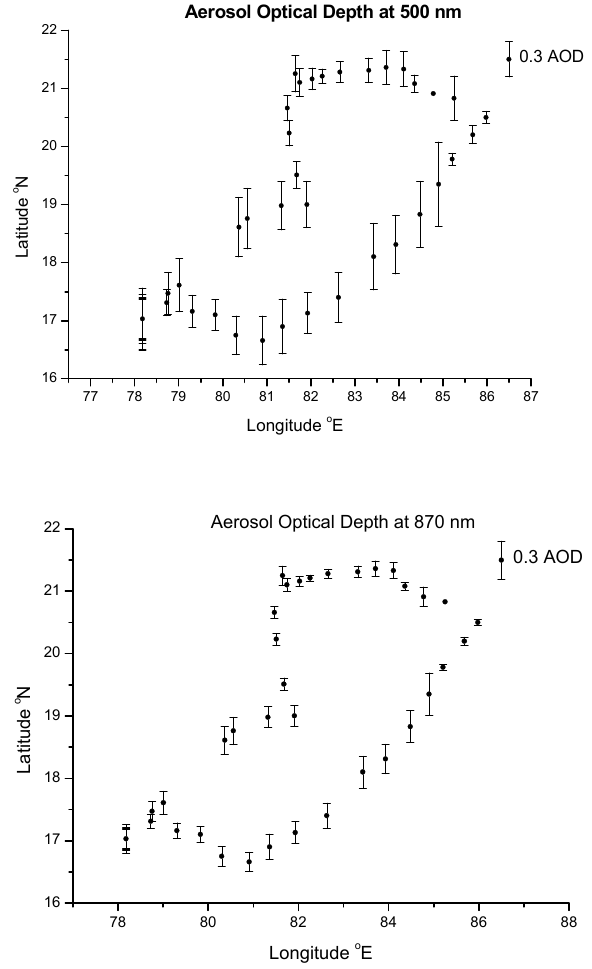
Fig. 4 Fig. 4. Aerosol spectral optical depths at 500nm (top panel) and